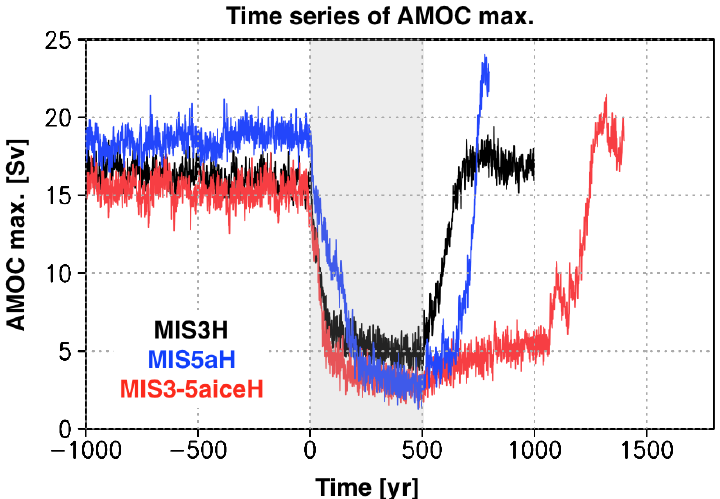
Figure 3. Time series of the strength of the AMOC under freshwater hosing. Freshwater of 0.1Sv was released to 50–70 ◦ N in the North Atlantic for 500 years from year 1 (gray-shaded period). Black: MIS3H, blue: MIS5aH, and red: